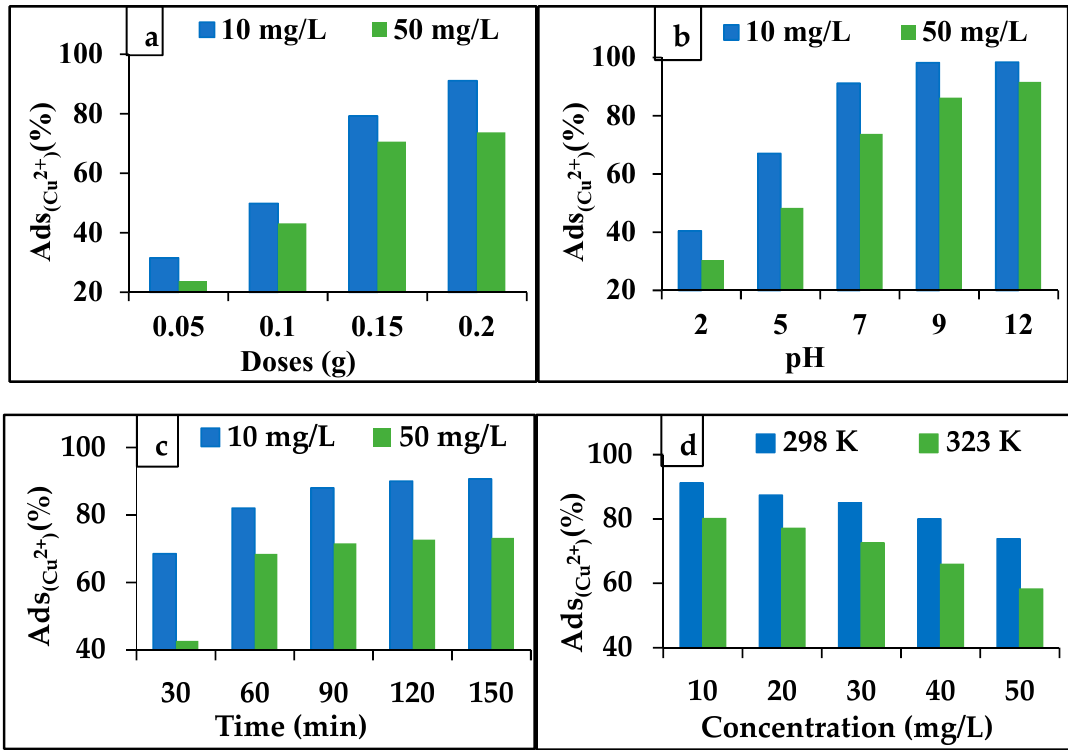
Figure 6. E ff ect of AgNPs’ dose on the adsorption percentage of Cu 2 + . ( a ) The e ff ect of pH, ( b ) the Figure 6. Effect of AgNPs’ dose on the adsorption percentage of Cu 2+ . ( a ) The effect of pH, ( b ) the contact time, ( c ) the Cu 2 + concentration and temperature, and ( d ) the adsorption percentage of Cu 2 + by contact time, ( c ) the Cu 2+ concentration and temperature, and ( d ) the adsorption percentage of Cu 2+ AgNPs (0.2 by AgNPs (0.2 g).